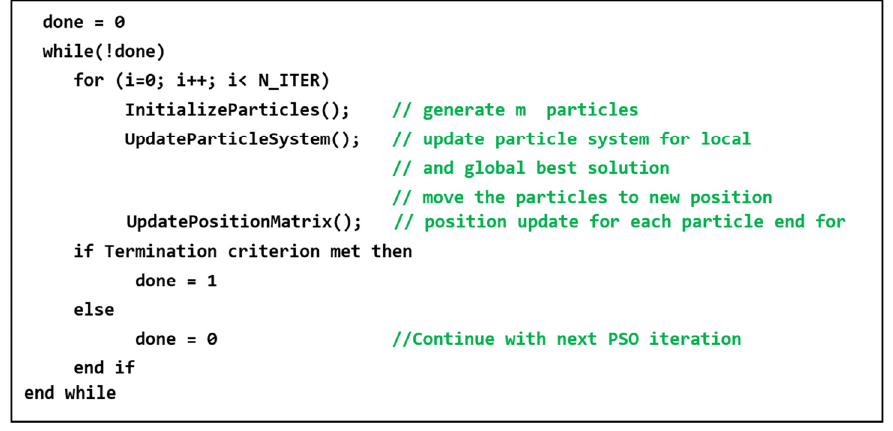
Figure 3. Particle swarm optimization (PSO) formulation for hybrid photonic NoC synthesis.